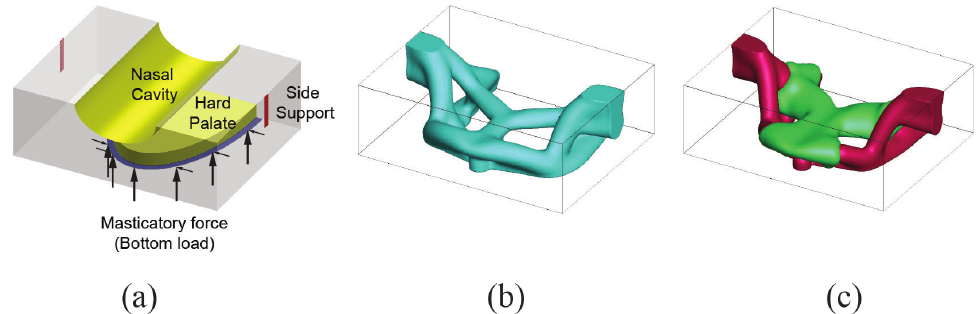
Figure 8. Case 2—Scenario 2: mastication loading has 2 components vertical and horizontal to- wards center. ( a ) Boundary condition used in the analysis, ( b ) bone replacement shape using single material topology optimization, ( c ) bone replacement shape using multi-material (2 materials) topology